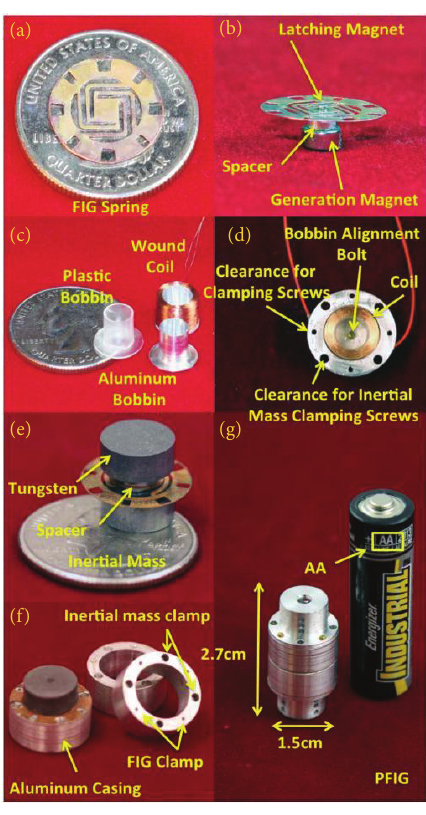
Figure 11: Fabrication of EM-VEH, reported by